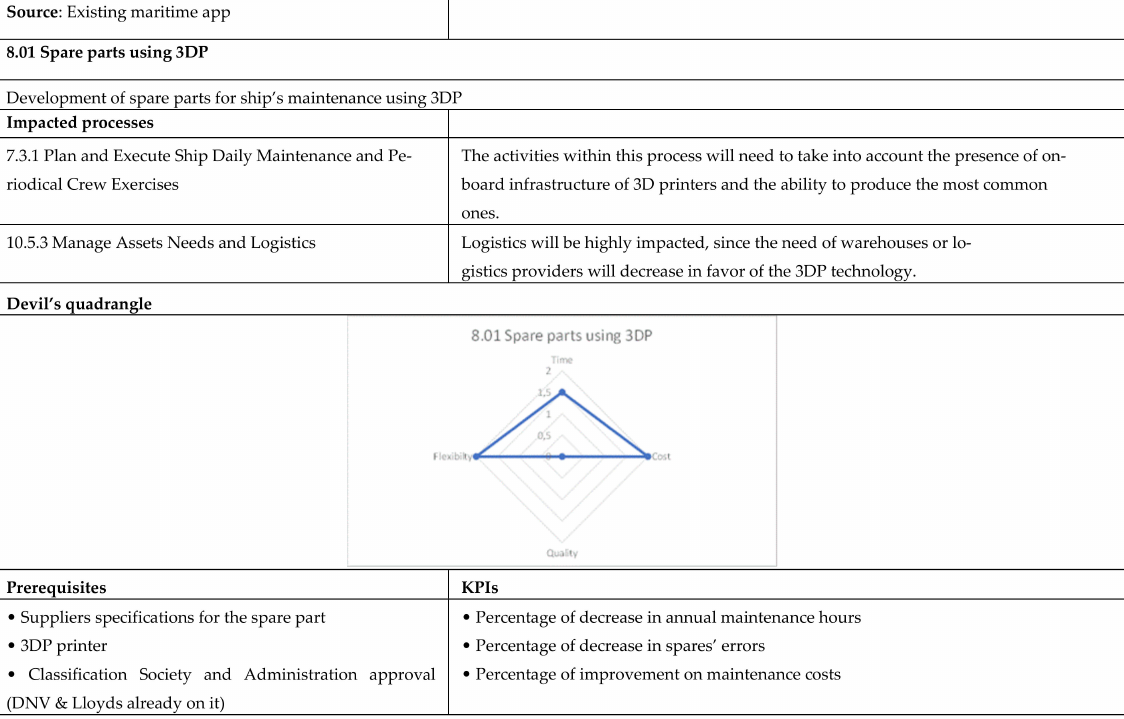
Figure A46. Spare parts using 3DP data